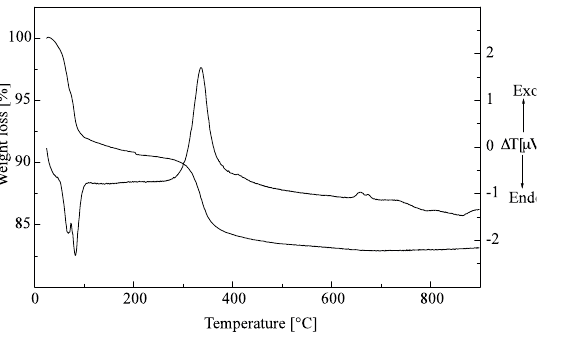
Figure 3. TG-DTA curves of the γ -TiPCdS In the DTA curve endothermic peaks (dehydration) and exothermic peaks at 350°C and at 680°C (CdS decomposition, cadmium double phosphate